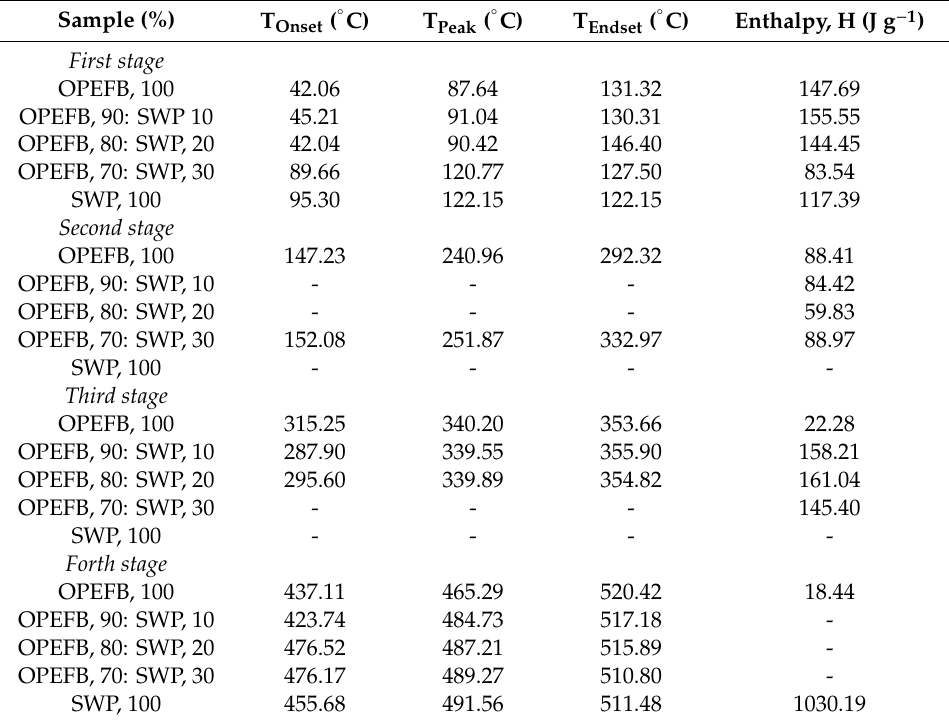
Table 4. DSC results of the